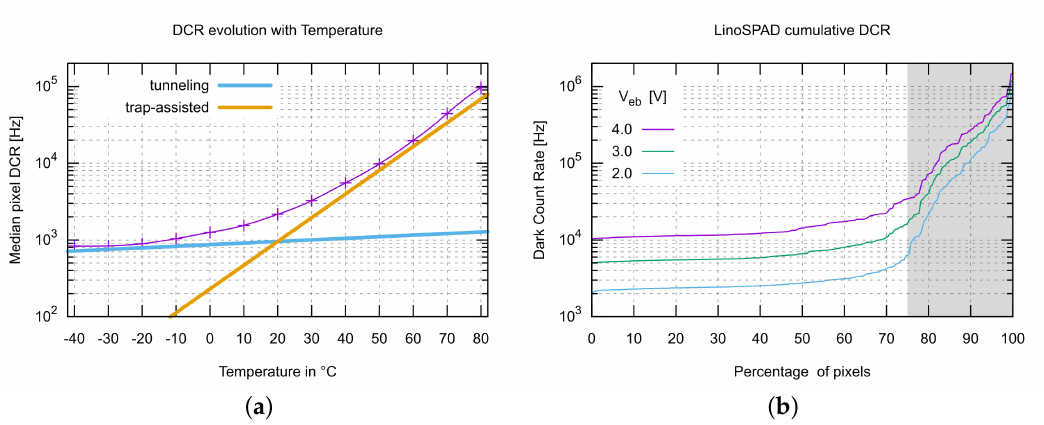
Figure 8. ( a ) Evolution of median dark count rate (DCR) when the sensor temperature varies from − 40 ◦ C to 80 ◦ C. These values were measured using 2 V excess bias voltage; ( b ) The noise is recorded for excess bias voltages between 2 V and 4 V at room temperature. LinoSPAD typically has about 25% of pixels where the DCR exceeds the median value by an order of magnitude. However, no spatial pattern is present in the noise